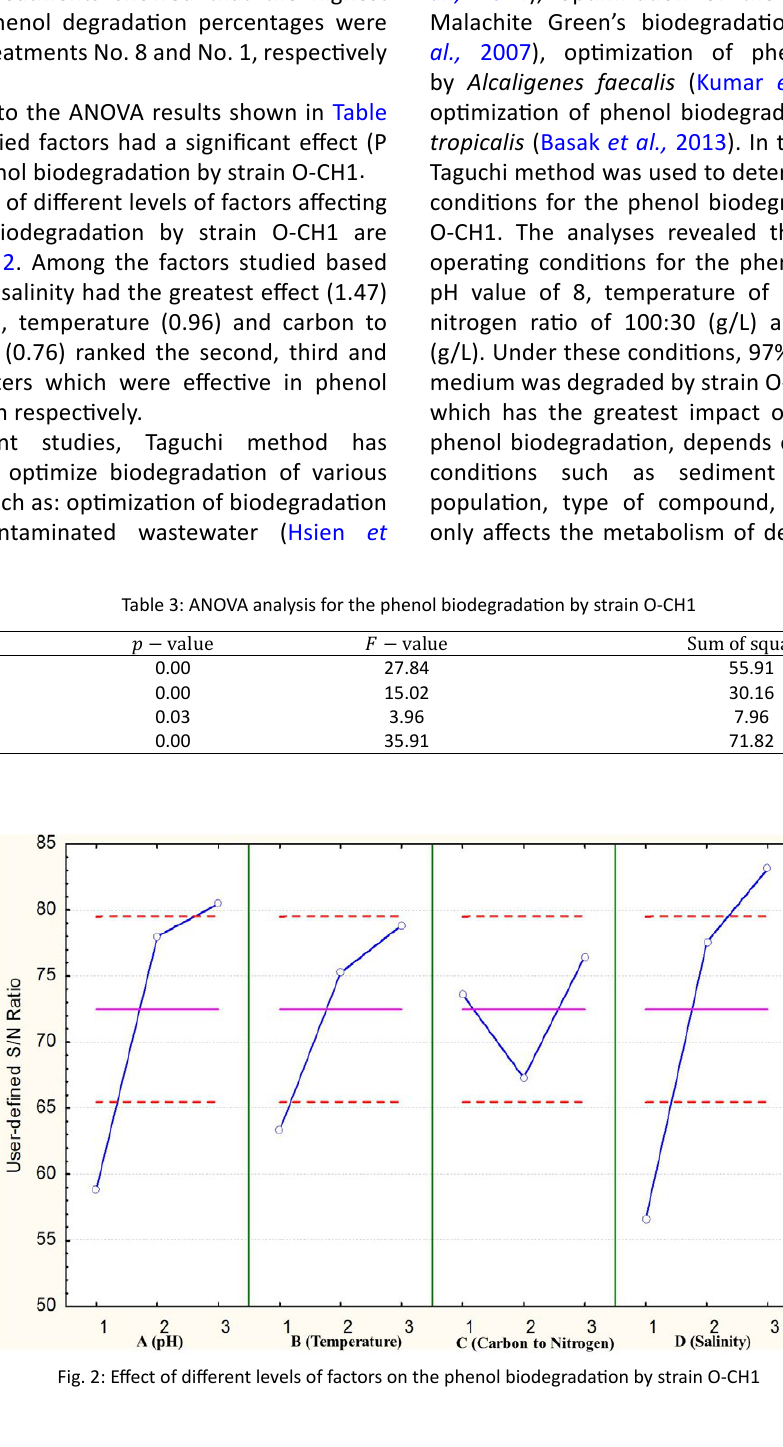
Fig. 2: Effect of different levels of factors on the phenol biodegradation by strain O‐CH1